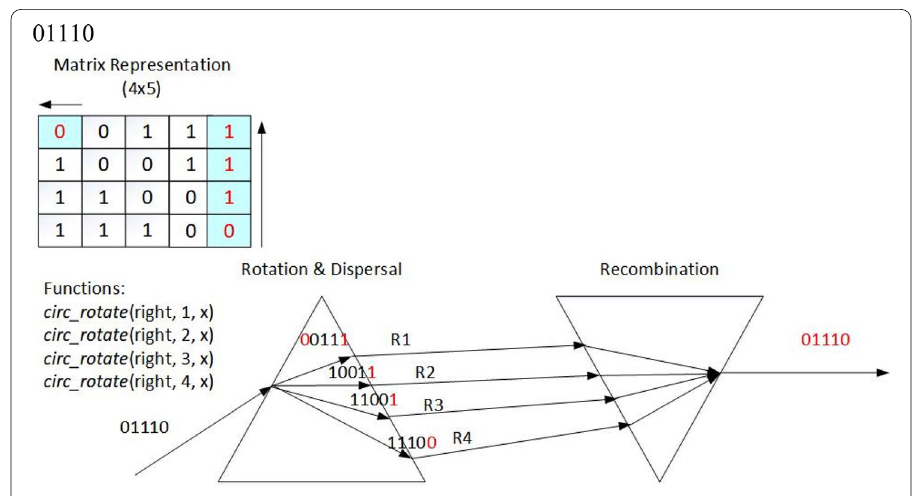
Fig. 11 Passing the classical bit string 01110 through the bit prism